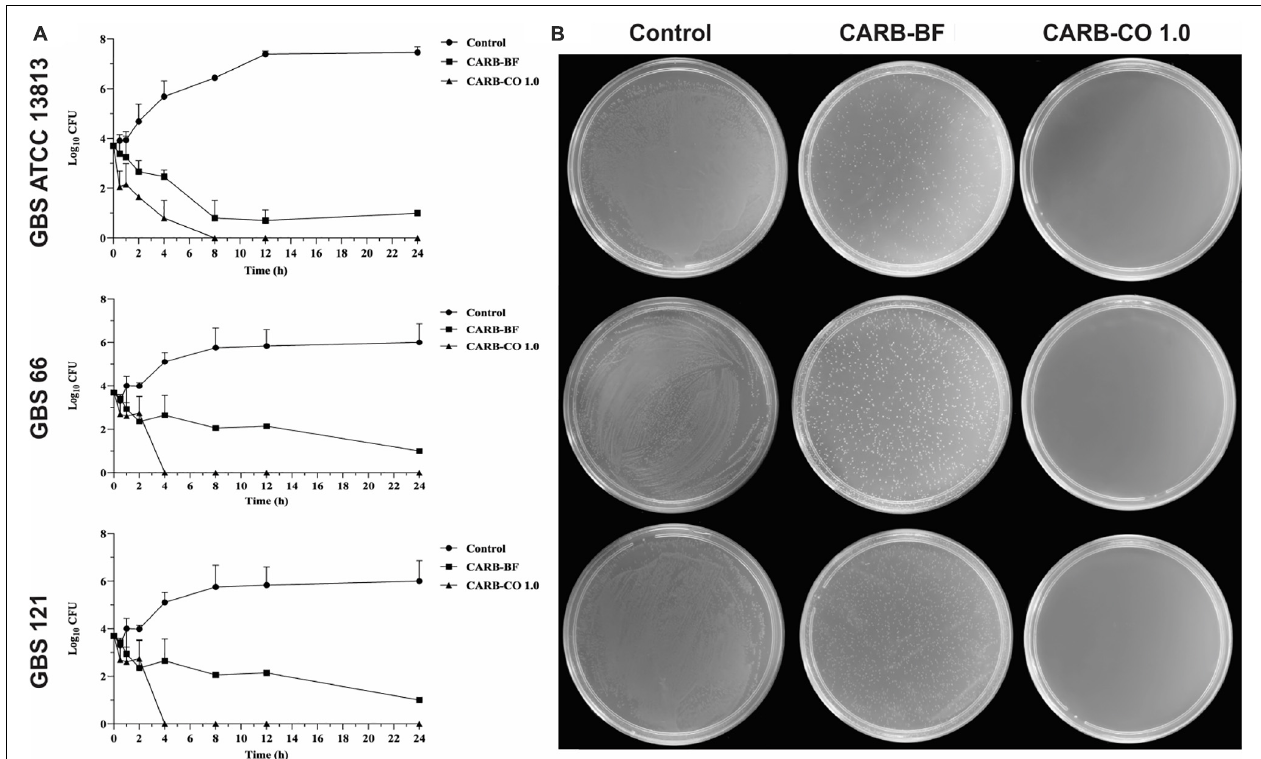
FIGURE 3 | Antibacterial activity of carbomer-based hydrogels on growth of planktonic cells of Streptococcus agalactiae . (A) Time-kill curve of S. agalactiae ATCC 13813; erythromycin and clindamycin-resistant GBS 66 strain; and erythromycin-resistant GBS 121 strain in presence of hydrogels. Bacteria were incubated with CARB-BF and CARB-CO 1.0 for 24 h at 37 ◦ C and the CFU counts per 10 µ L were determined at specified time points. GBSs without treatment were used as growth control. (B) TSA plate assay. Values are mean ± standard deviation of two